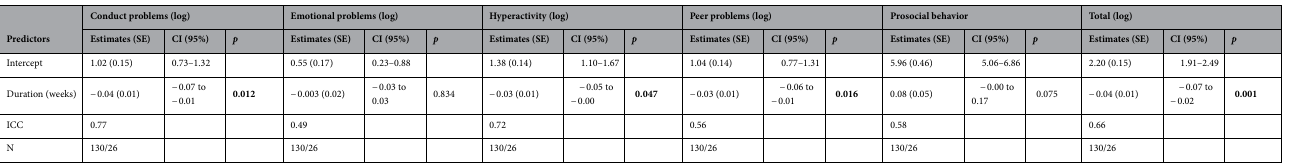
Table 3. Linear mixed models estimating the effect of time after Covid-19 onset on children’s behavioral and emotion problems. SE standard error, CI confidence interval, Duration (weeks) fixed effect, weeks passed since restrictions have been introduced, ICC intraclass correlation coefficient, N (number of observations)/(number of participants), p values have been estimated using Satterthwaite approximation, significant effects in